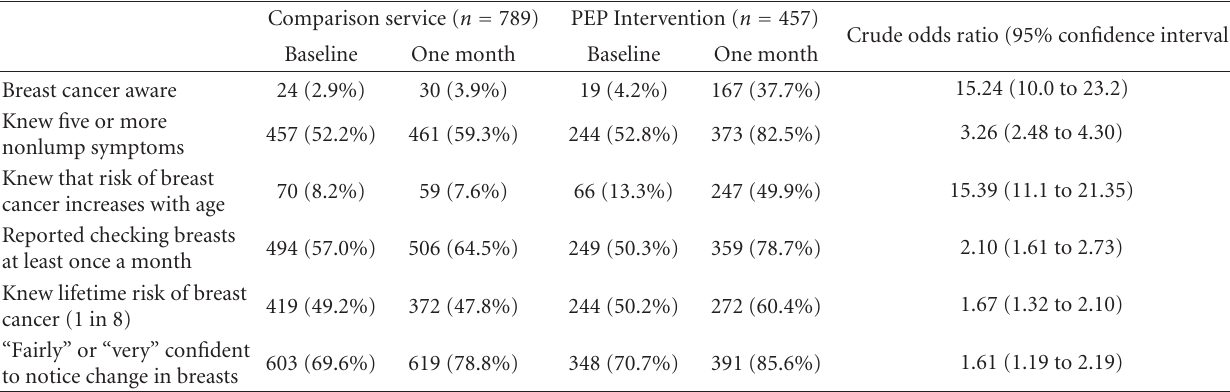
Table 2: Change in breast cancer awareness and confidence to notice a breast